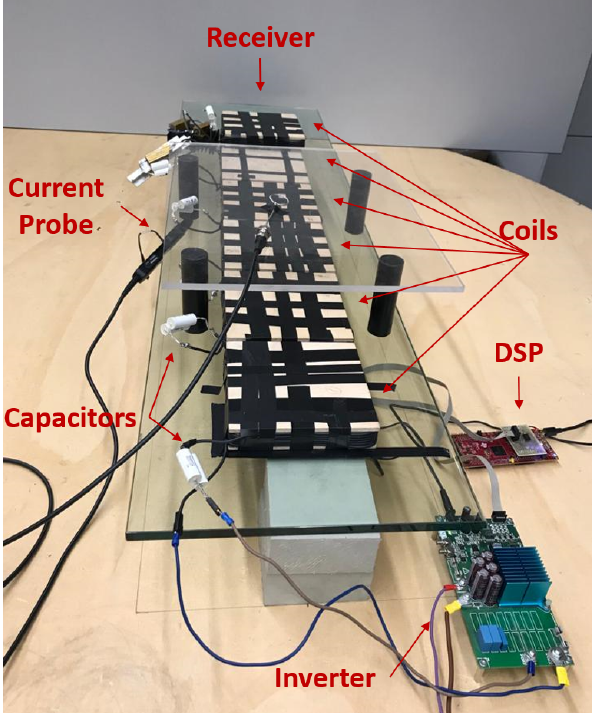
Figure 20. Experimental